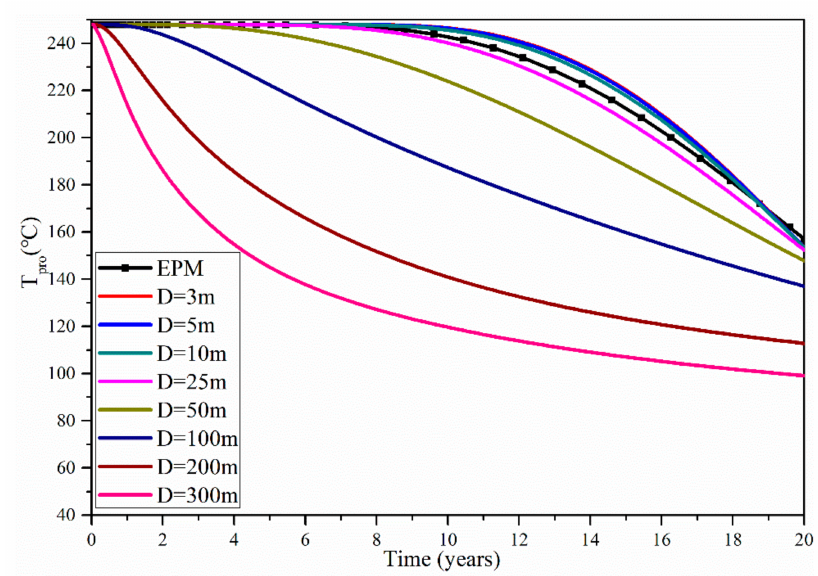
Figure 4. Evolution of production temperature of the EPM method and the MINC